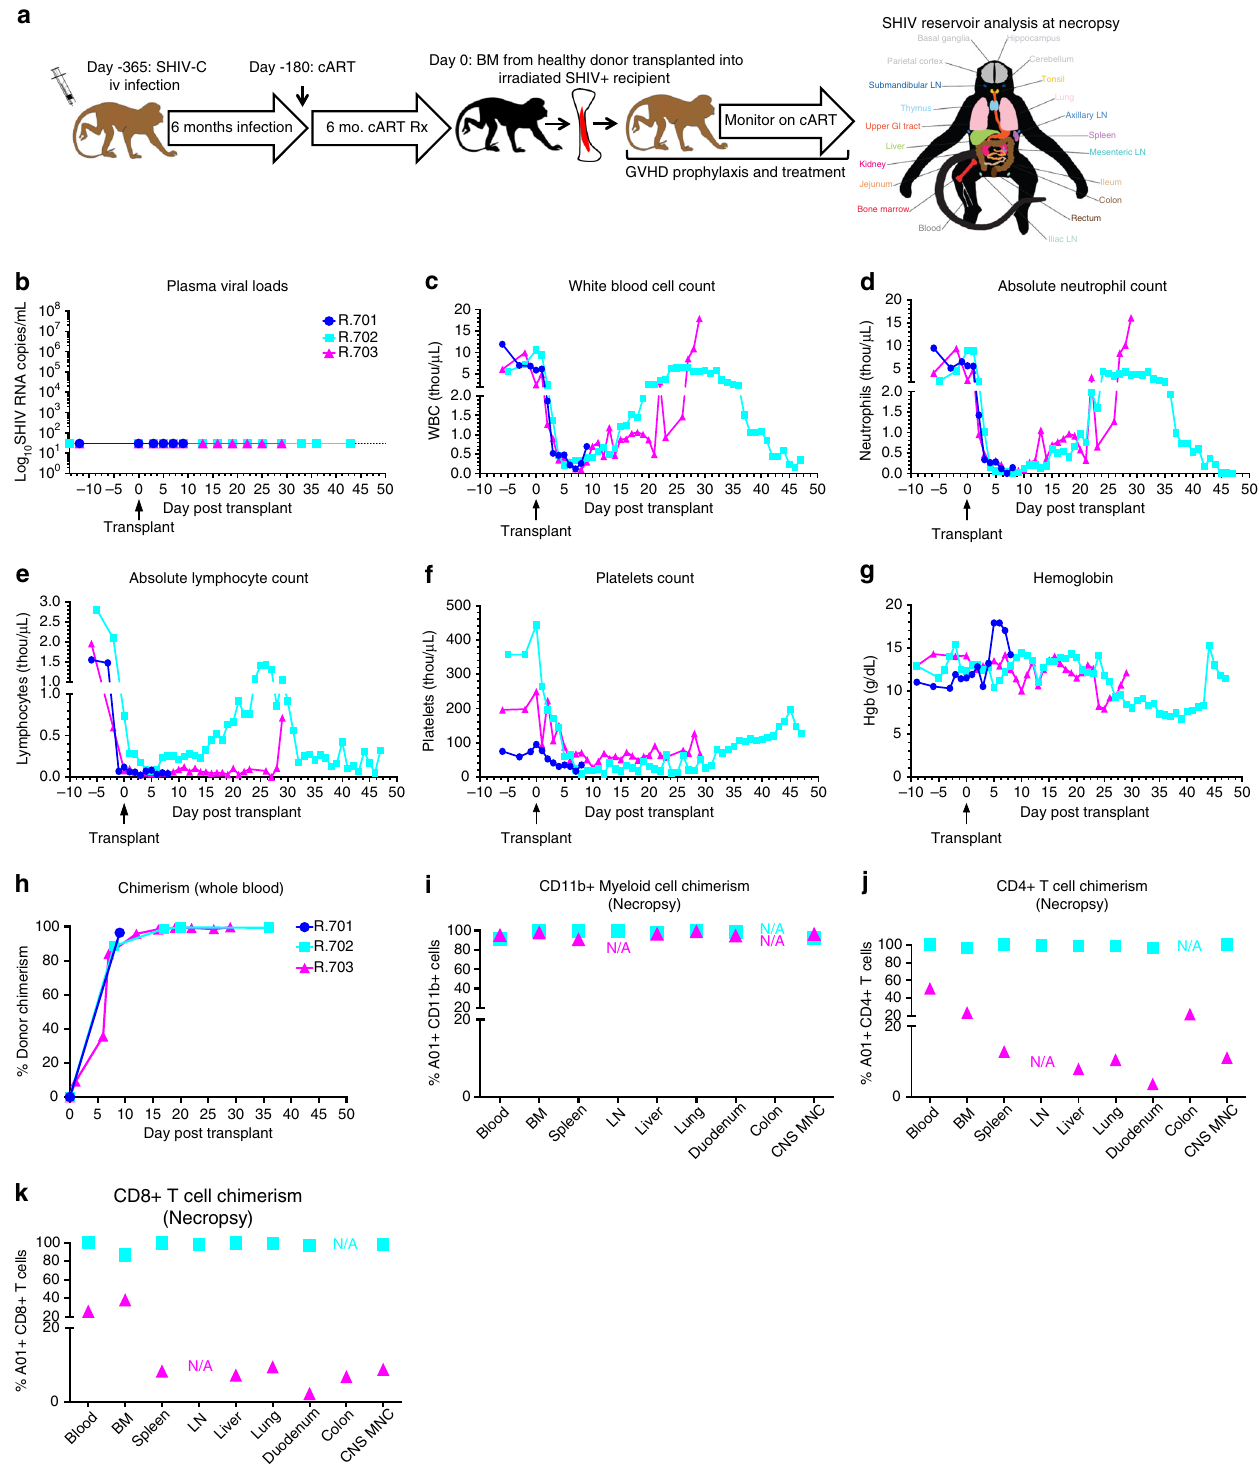
Fig. 3 Allogeneic HCT in SHIV-C Infected, cART-treated RM. a Schematic of SHIV-C infection and allogeneic bone marrow transplantation strategy in SHIV-C infected, cART-treated RM. b Plasma Viral Loads (PVL) were measured longitudinally following transplant as speci fi ed in Fig. 1a. c White blood count (WBC) (×10 3 / µ L). d Absolute Neutrophil Count (ANC) (×10 3 / µ L). e Absolute Lymphocyte Count (ALC) (x10 3 / µ L). f Platelet Count (PLT) (×10 3 / µ L). g Hemoglobin (Hgb) concentration (g/dL). h Percent whole blood donor chimerism, measured by microsatellite analysis. i Percent donor myeloid (CD11b + CD3-) chimerism, measured fl ow cytometrically. j Percent donor CD4 + T cell (CD3 + CD4 + CD8 − CD20 − CD11b − lymphocytes) chimerism, measured fl ow cytometrically. k Percent donor CD8 + T cell (CD3 + CD8 + CD4 − CD20 − CD11b − lymphocytes) chimerism, measured by fl ow